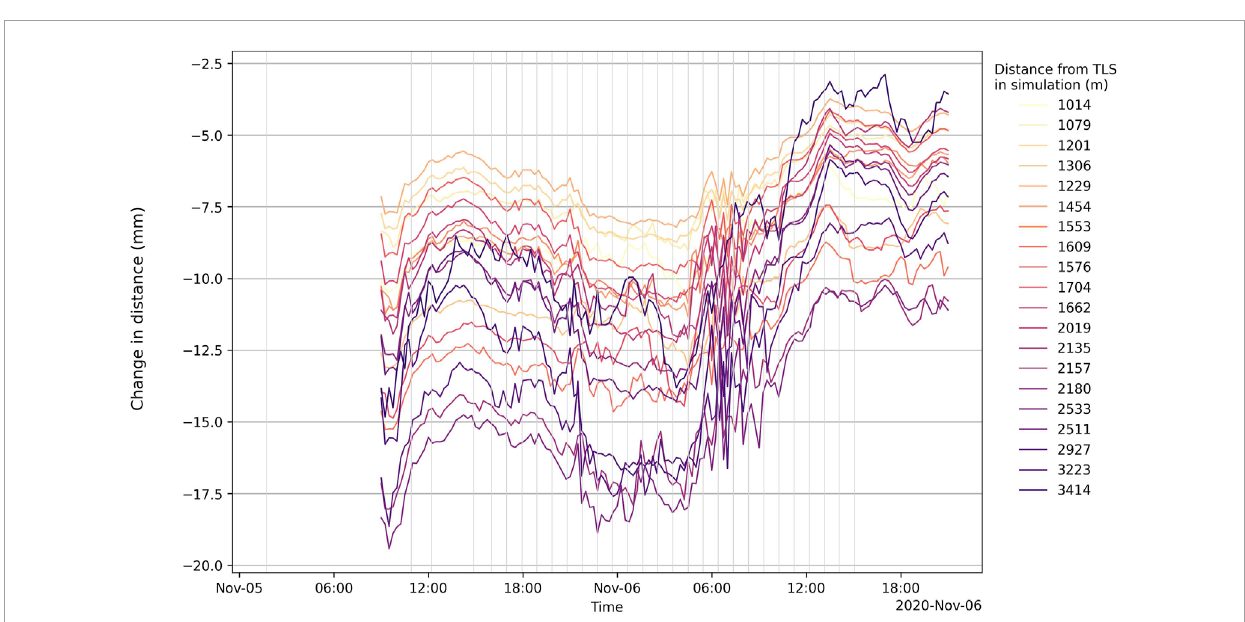
FIGURE 7 Change in the distance traveled by the laser beam in mm for 20 different areas over time ( Y -axis). The legend shows the distance of the TLS to the simulated coordinates. The vertical gray lines denote the time a new scan was started. The temporal resolution of LES simulation is 15 min.